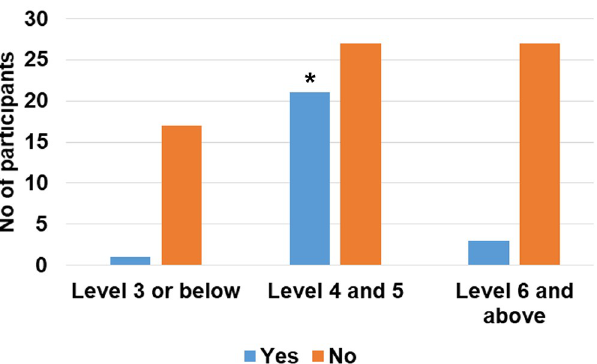
Fig 3. Participants with an education level 4 or 5 requested assistance more frequently. Number of participants having asked for a supervisor’s assistance according to education level ( � χ 2 p < 0.05 vs. education level 3 and below or level 6 and